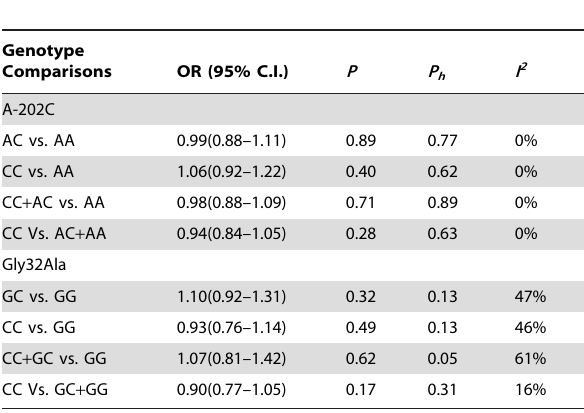
Table 2. Results of meta-analysis for IGFBP3 A-202C/Gly32Ala polymorphism and colorectal